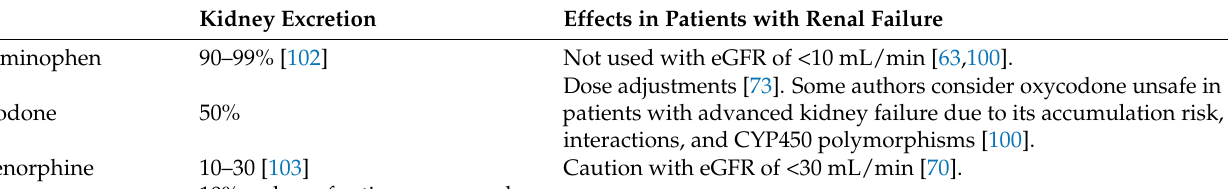
Table 4. Effects of analgesic drugs in patients with renal failure. eGFR: glomerular filtrate